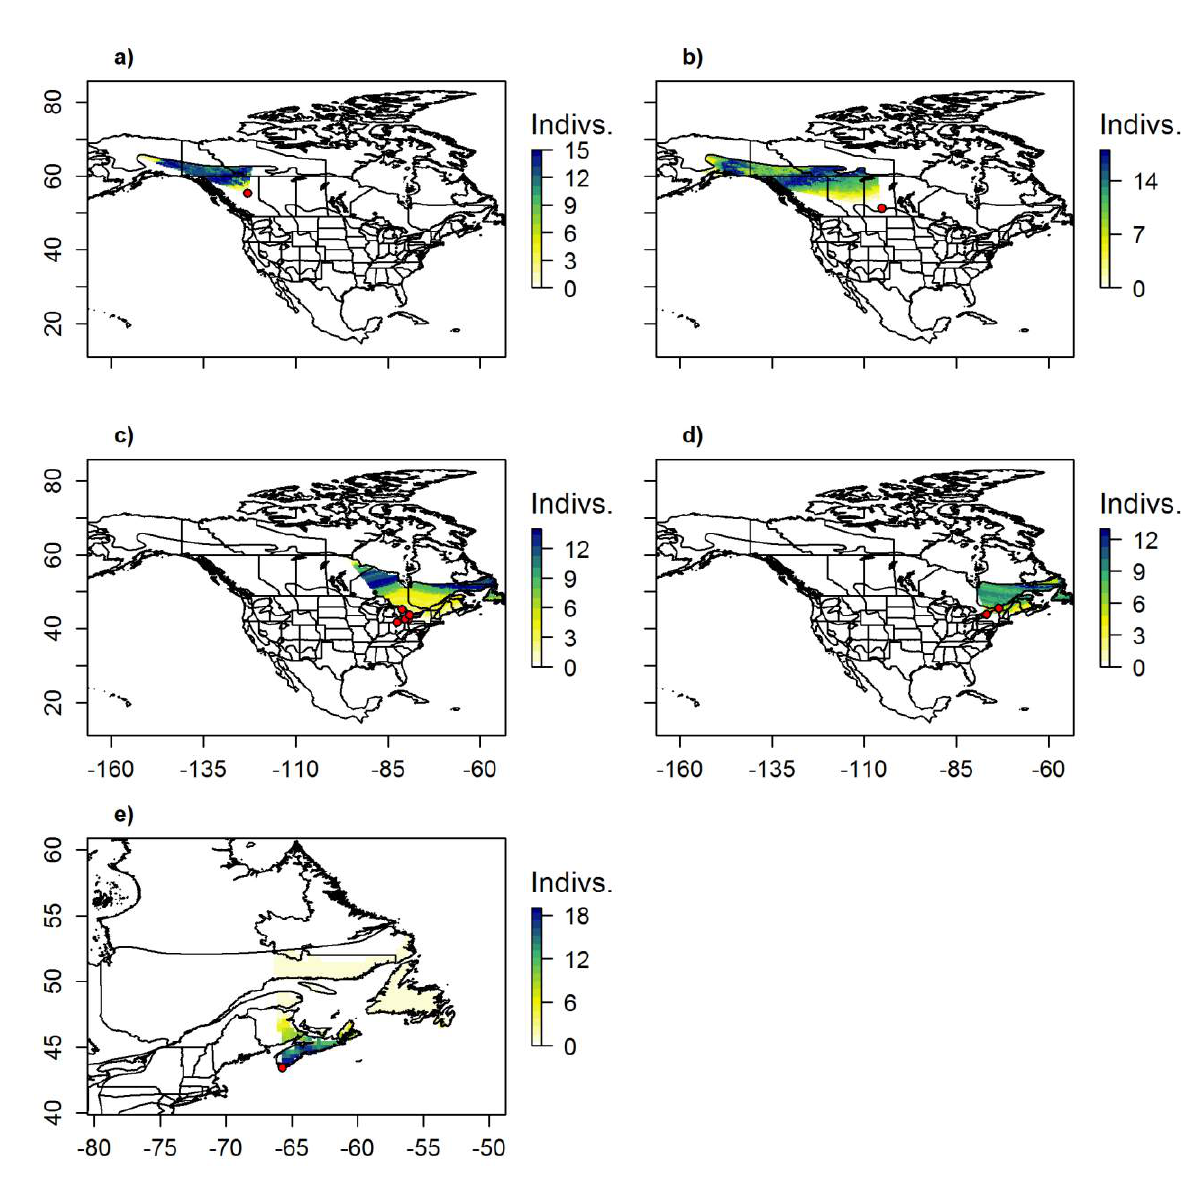
Figure A2.5: Probable origins of Hermit Thrushes ( Catharus guttatus ) captured during fall migration at Canadian Migration Monitoring Network (CMMN) stations in a) Northern British Columbia (MNO (n=17)); b) Saskatchewan (LMBO (n=20)); c) Southwest Ontario (BPBO (n=5), HBO (n=4), LPBO (n=4), PIBO (n=2), TTPBRS (n=5)); d) Southeast Ontario & Southwest Québec (MBO (n=7), PEPTBO (n=13)); and e) Eastern Canada (ABO